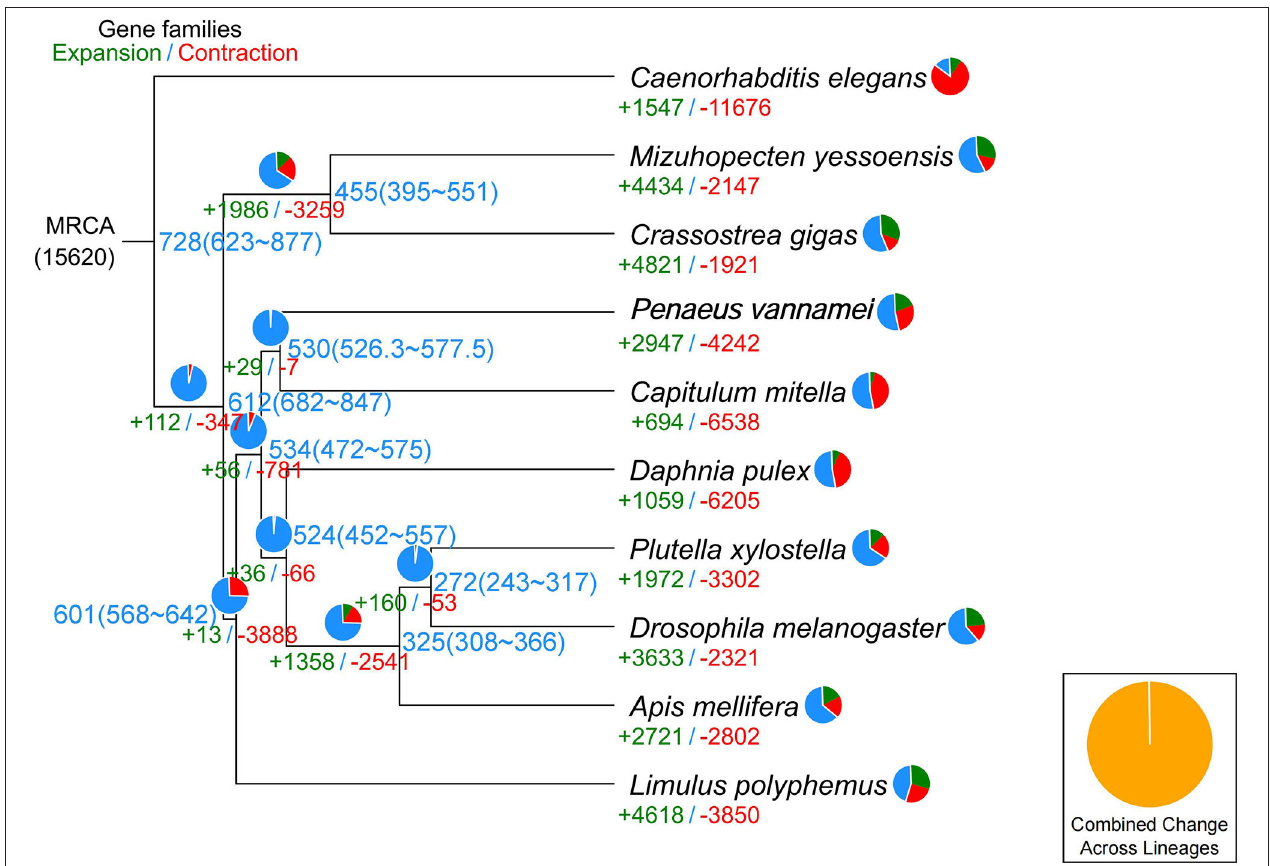
FIGURE 3 | Phylogenetic tree showing the number of gene families displaying expansion (green) and contraction (red) among 10 animal species. The pie charts show the proportions of expanded (green), contracted (red), and conserved (blue) gene families among all gene families. The estimated divergence time (million years ago) is displayed in the phylogenetic tree in black. MRCA, most recent common